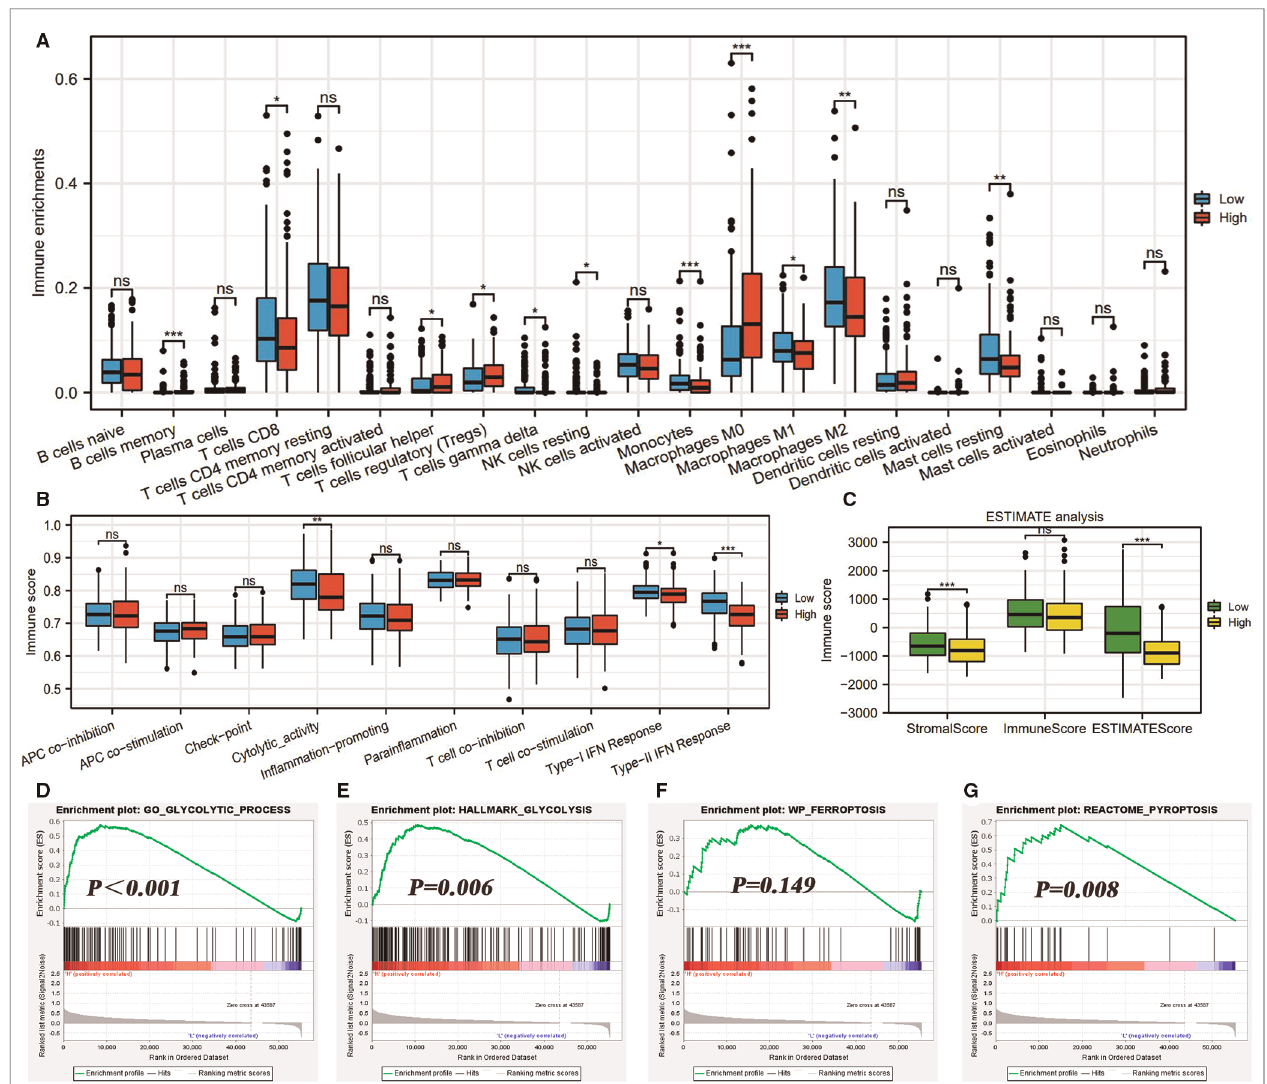
FIGURE 6 | Effects of the m7G risk score on TIM. ( A ) Differences in in fi ltrating levels of 21 immune cells between high- and low-m7G-risk groups based on the CIBERSORT algorithm. High m7G risk is red, and low m7G risk is blue. ( B ) Differences in activities of 10 immune-related pathways between different m7G risk groups based on the ssGSEA algorithm. ( C ) Differences in immune scores between different m7G risk groups based on the ESTIMATE method. ( D – G ) Effects of m7G risk levels on the enrichments of glycolysis, ferroptosis, and pyroptosis based on GSEA analyses. TIM, tumor immune microenvironment; GSEA, gene set enrichment analysis; * P <0.05, ** P <0.01, *** P